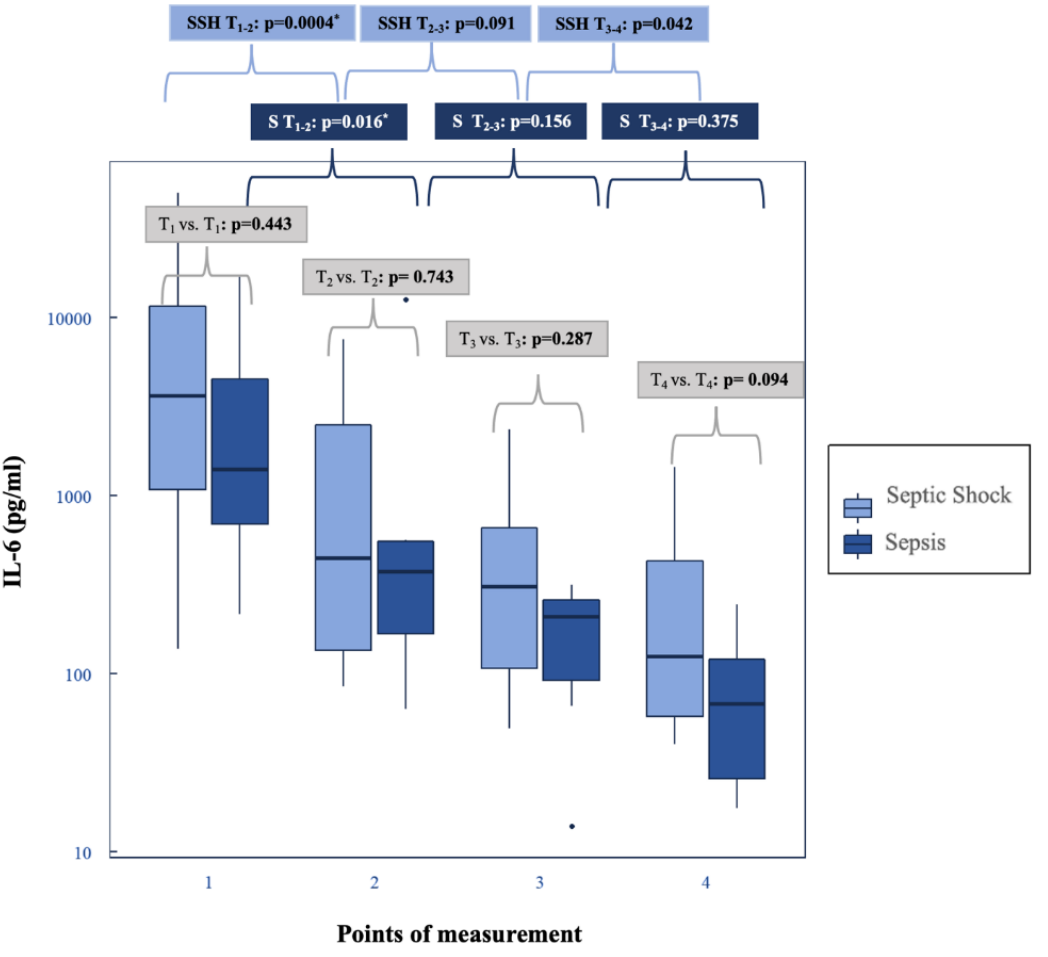
Figure 3. IL-6: sepsis vs. septic shock and the progression in the subgroups. IL-6: LiMAx ® : grey rectangle: p -values of septic shock vs. sepsis; dark blue rectangle: p -values of the subgroup sepsis (S); light blue rectangle: p -values of the subgroup septic shock (SSH); *: statistically significant. Box- whisker plot: bold lines: medians; box plots: 25th to 75th percentiles; box-whisker plots: illustrate median value with interquartile range; outliers are shown as separate points.